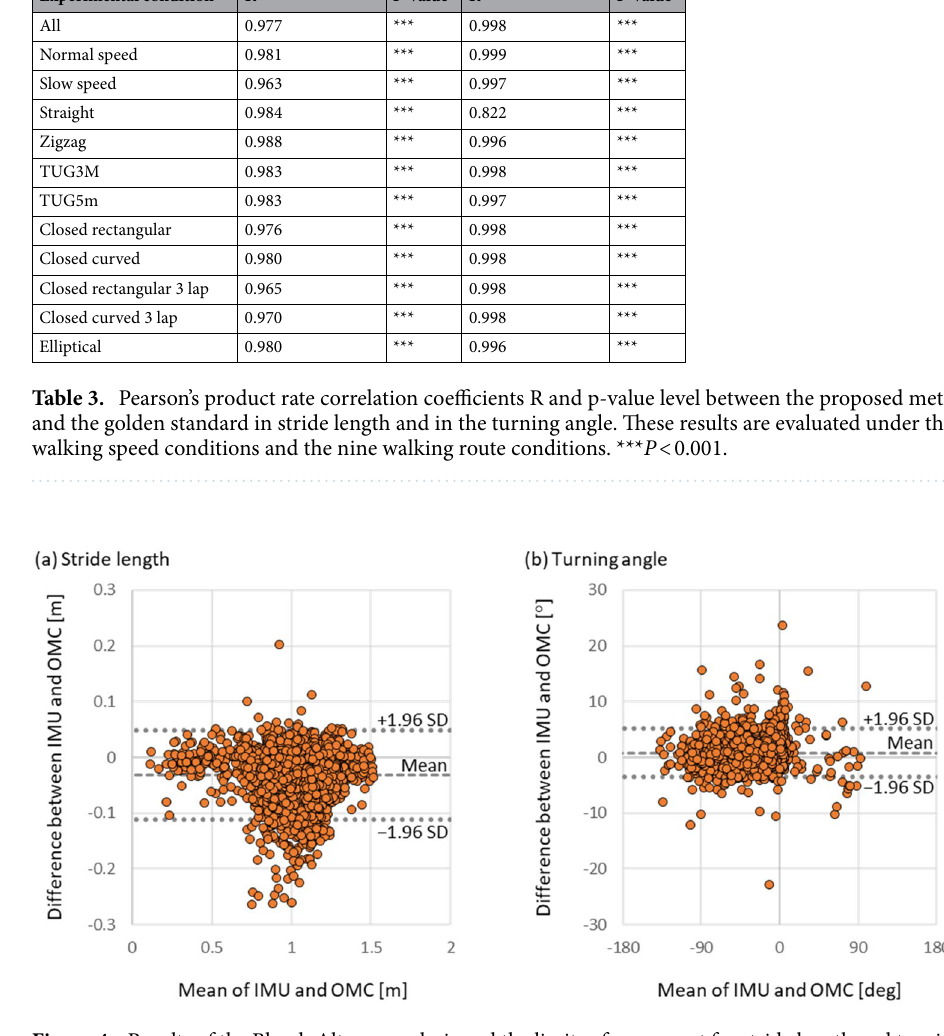
Figure 4. Results of the Bland–Altman analysis and the limits of agreement for stride length and turning angle in all experimental trials conducted under all conditions. IMU means the proposed method and OMC means the golden standard as the ground